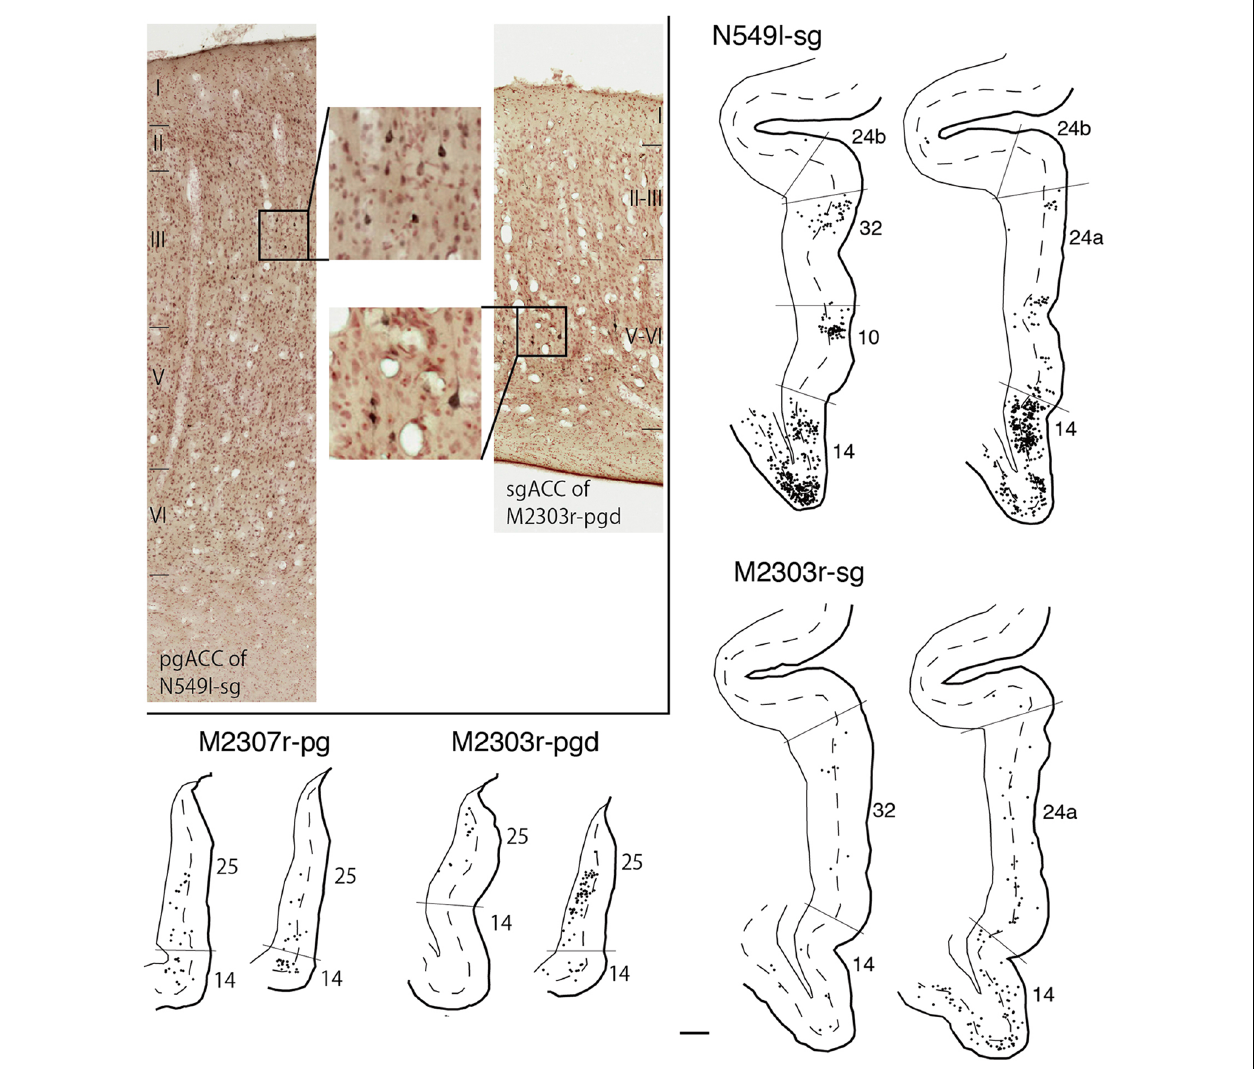
FIGURE 10 | Distribution of the labeled neurons in the pgACC after tracer injection into sgACC (N549l-sg and M2303r-sg), and in the sgACC after injection into pgACC (M2307r-pg and M2303r-pgd). Inset: photomicrographs of the pgACC of N549l-sg (left) and the sgACC of M2303r-pgd (right). Labeled neurons are scattered in the supragranular layers in the former case and in the deep layers in the latter case. Scale bar: 1